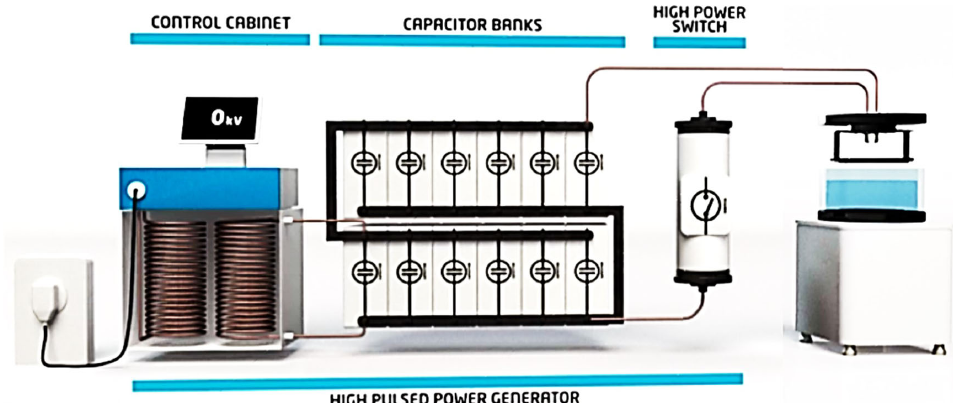
FIG. 1. Equipment used for electrohydraulic forming